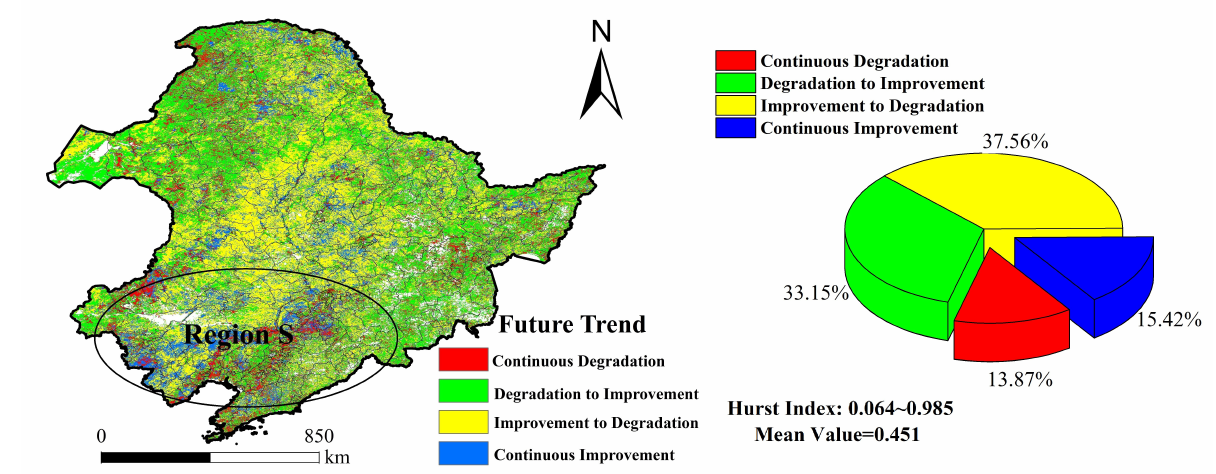
Figure 11. Distribution of hurst in Northeast China and its percentages.